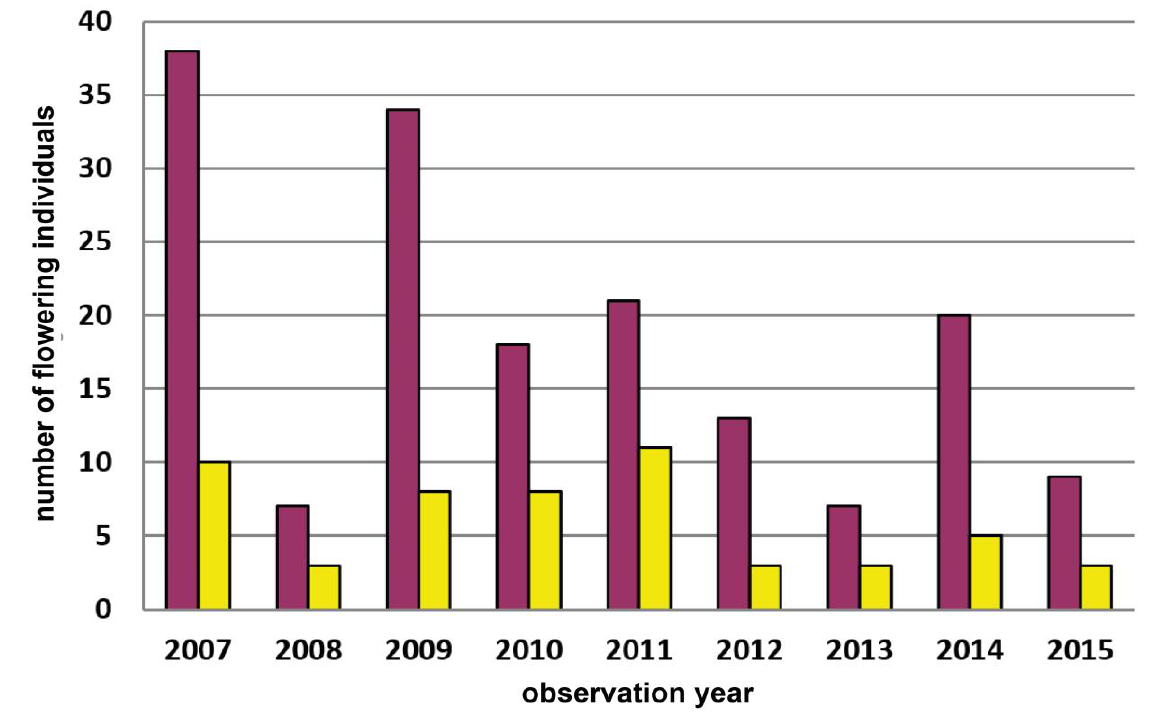
Figure A5. Population census (2007 – 2015) of Dactylorhiza sambucina -population Höhereck near Dürnstein in the Wachau region. Red columns = red-flowering plants and yellow columns = yellow- flowering plants.